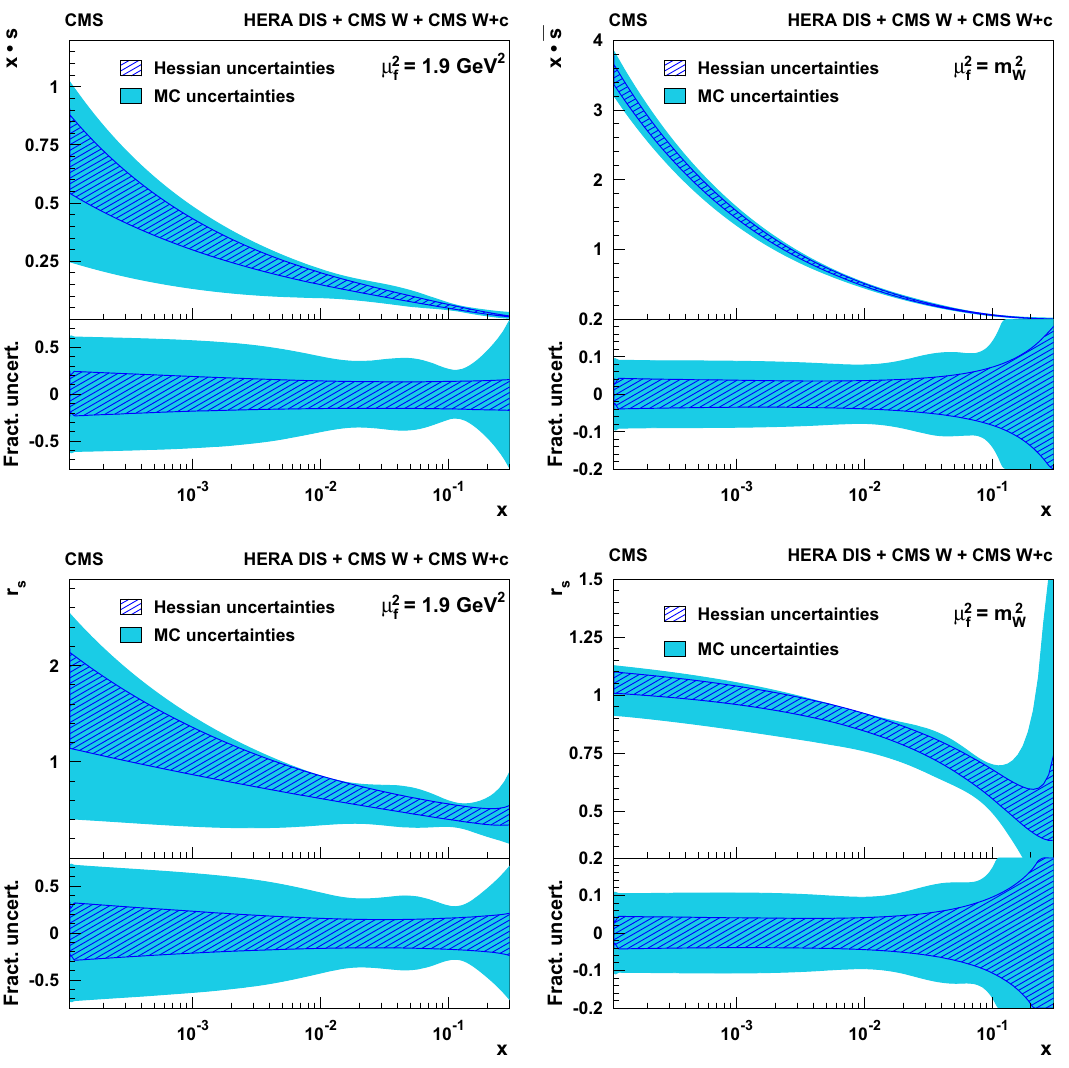
Fig. 6 The s quark distribution (upper) and the strangeness suppres- sion factor (lower) as functions of x at the factorization scale of 1.9GeV 2 (left) and m 2 (right). The results of the current analysis are presented W